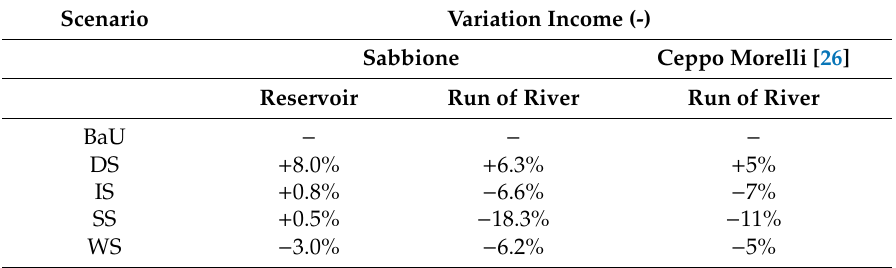
Table 7. Comparison of the income variation between RoR and reservoir configuration in the case of di ff erent price scenarios for Sabbione and income of RoR obtained by Gaudard et al. [26] for Ceppo